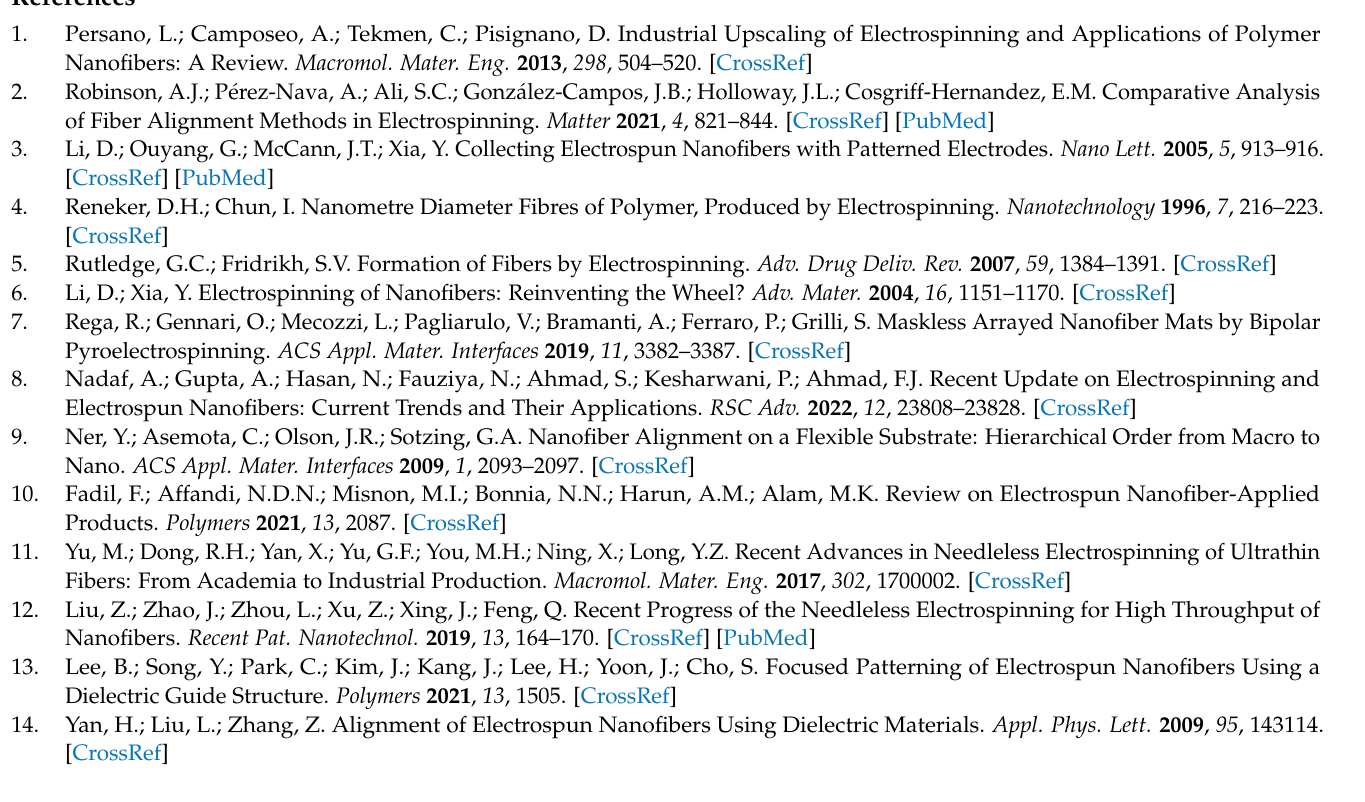
of the heart loop method. Figure S2: Photographs of macroscopic appearance of fiber mats; Table S1: Effect of mesh size on fiber size and fiber size distribution; Table S2: Basis weight and bending length of electrospun samples. Figure S3: Representative optical microscopy images of various sections of the hood (front, side,